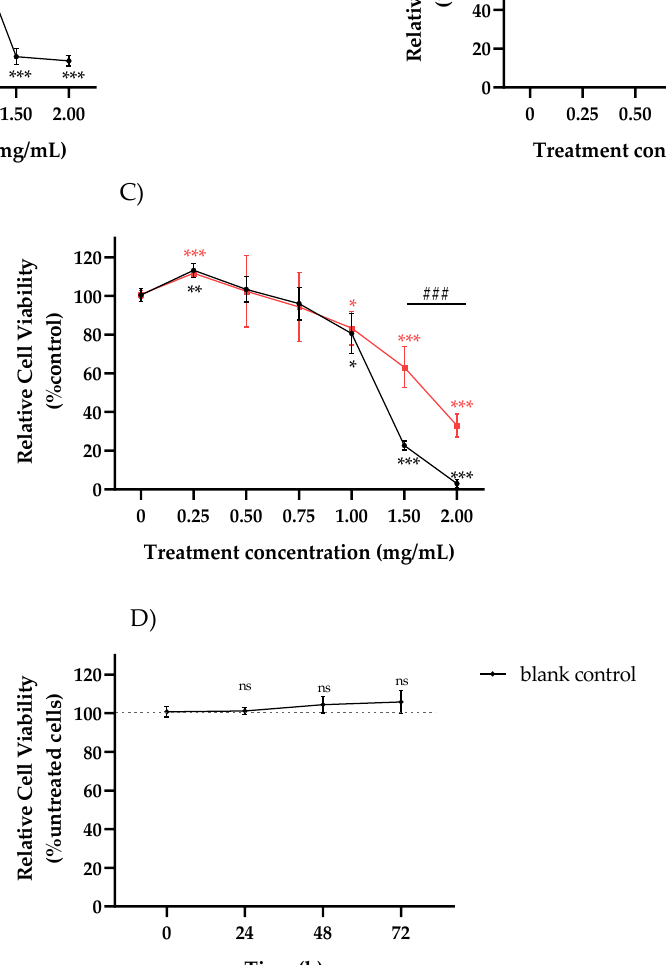
Figure 1. Evaluation of response to digested or not-digested coffee samples in HT-29 cells. The effect of treatment with not-digested or digested coffee extract at 0.25, 0.50, 0.75, 1.00, 1.50, and 2.00 mg/mL on cell viability was estimated by MTT assay after 24 h ( A ), 48 h ( B ), and 72 h ( C ) as compared to untreated control. The effect of treatment with vehicle (blank control) resulting from in vitro digestion on cell viability was evaluated by MTT assay after 24 h, 48 h, and 72 h ( D ), as compared to untreated cells. No significant differences were observed between blank control and untreated cells. ns: not statistically significant. Mean ± SD of three independent experiments were plotted on the graph. Differences were considered significant when p- value ≤ 0.05 and p -value ≤ 0.01 and highly significant when p -value ≤ 0.001. * p ≤ 0.05, ** p ≤ 0.01, and *** p ≤ 0.001 versus untreated control (calculated as fold-change relative to untreated cells, arbitrarily set at 100%); # p ≤ 0.05, ## p ≤ 0.01, and ### p ≤ 0.001 not-digested coffee versus digested coffee.